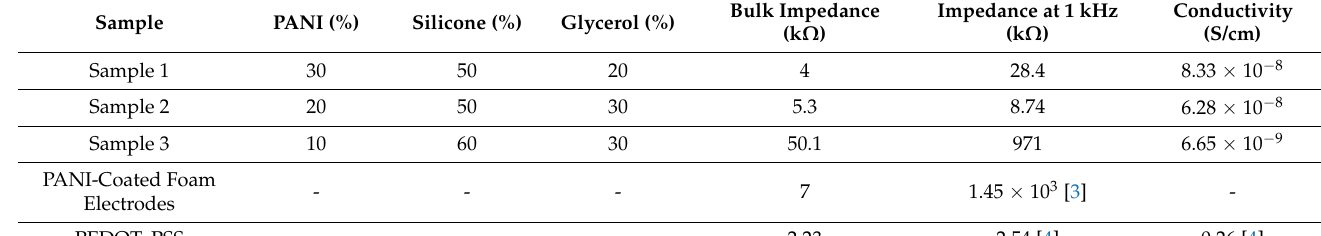
Table 2. Comparison between different prepared electrode mass compositions.